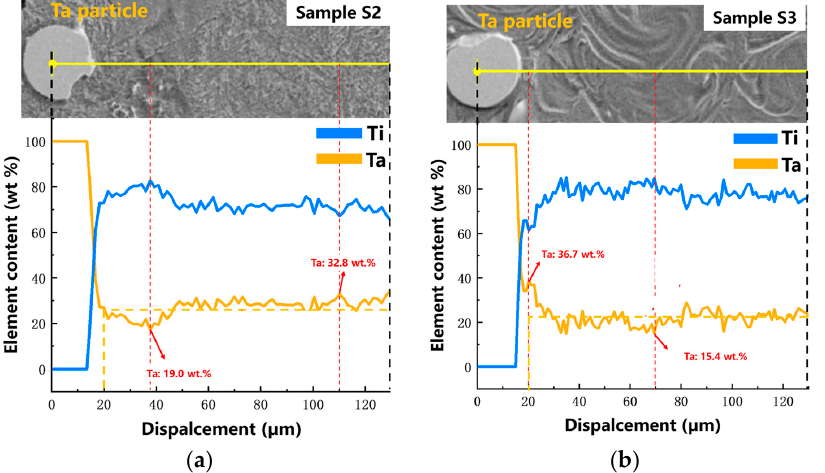
Figure 7. EDS linear scan results of LPBF Ti ‐ Ta with different building parameters: ( a ) sample S2 (v = 220 mm/s, E = 381 J/mm 3 ), and ( b ) sample S3 (v = 1100 mm/s, E = 76 J/mm 3 ).